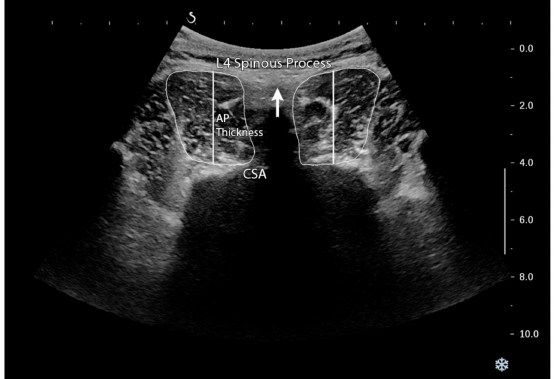
Figure 1. Cross-sectional area (CSA) and anteroposterior (AP) thickness measurements at the L4–L5 vertebral level.